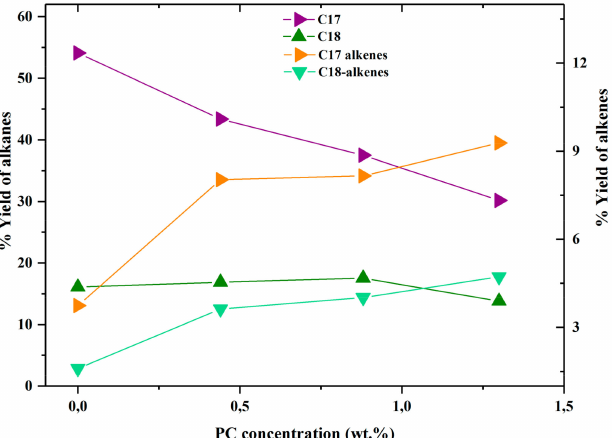
Figure 4. Effect of phospholipid (PC) on the formation of C17 and C18 alkanes/alkenes at the end of a 4 h